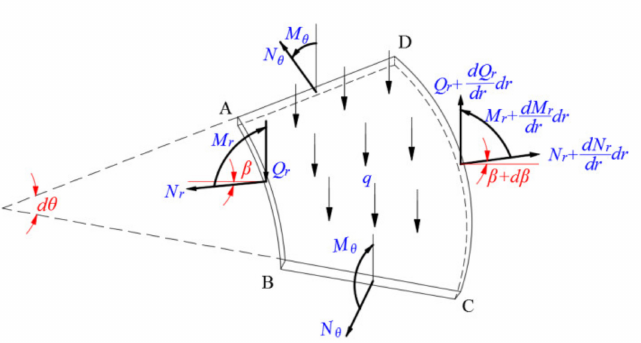
Figure 2. The equilibrium of internal forces of differential element